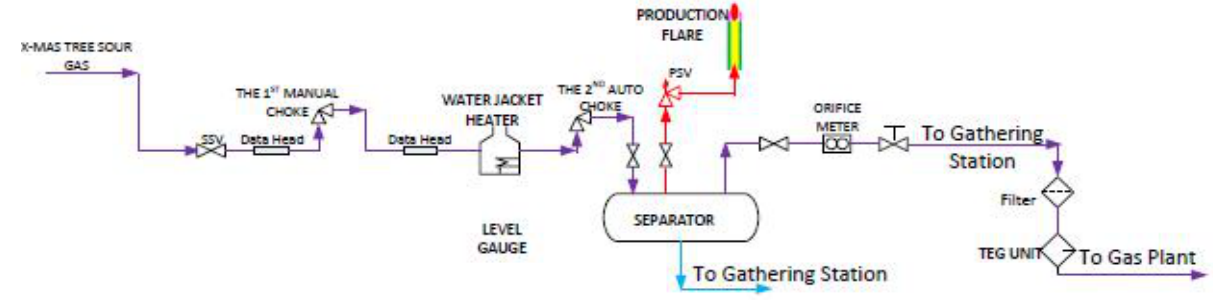
Figure 3—Schematics of two-choke production system.